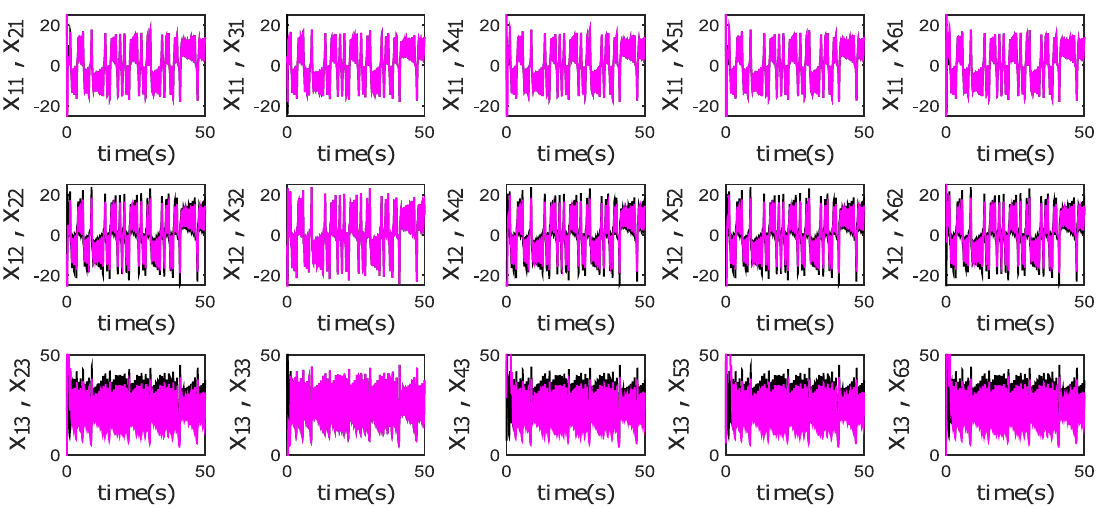
Fig 15. Output Synchronization, phase synchronization and complete synchronization for different chaotic systems in a Tree topology.